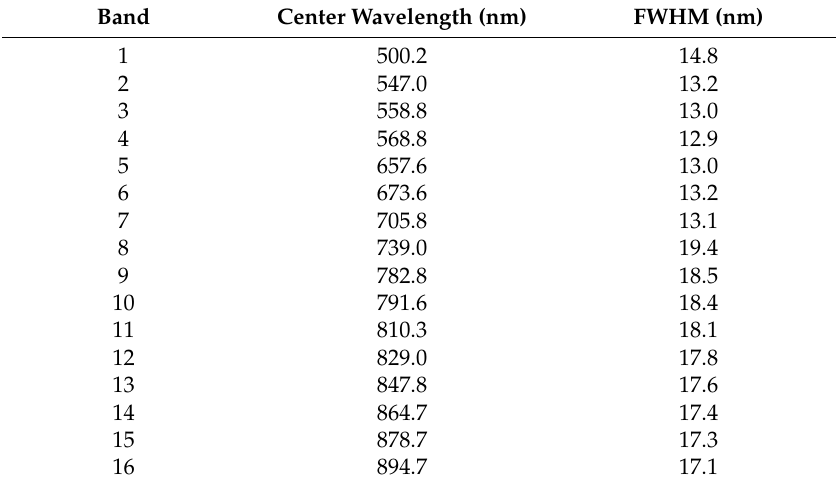
Table 3. Center wavelengths and Full-Width-at-Half-Maximum (FWHM) of the 16 spectral Rikola bands used in this